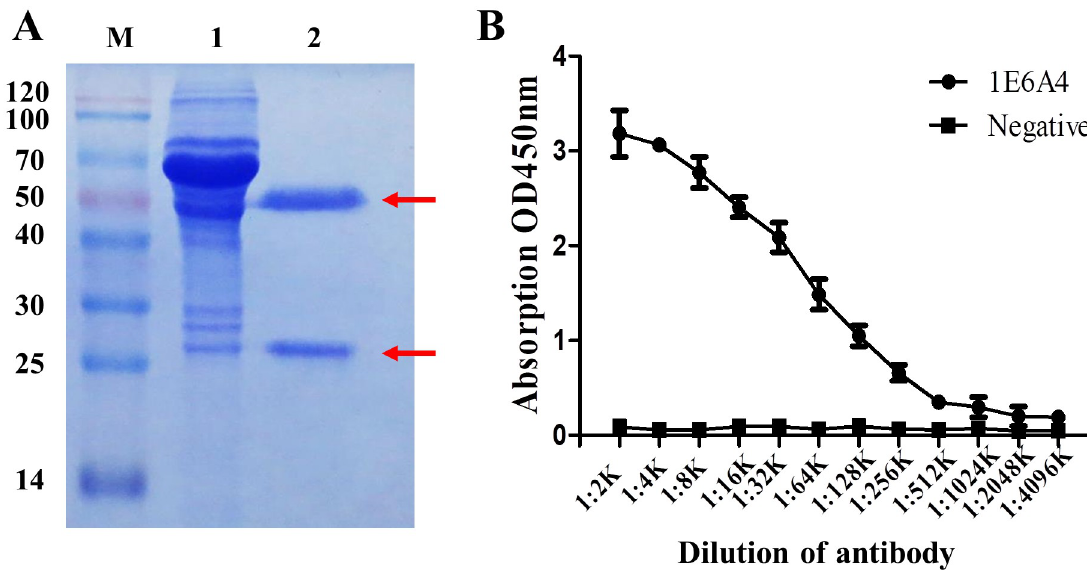
Fig 3. Purification of antibody against BCL6. (A) SDS-PAGE analysis of antibodies against BCL6 after purification. M: Marker (Blue plus II protein marker); lane 1: protein profile of ascites fluid; lane 2: the purified mAb against BCL6 (1E6A4). The bands shown with arrows indicate heavy and light chains respectively from 1E6A4 antibodies. (B) Determiantion of the 1E6A4 antibody titer with iELISA. BCL6 1-350 antigens were coated, and antibodies were diluted as